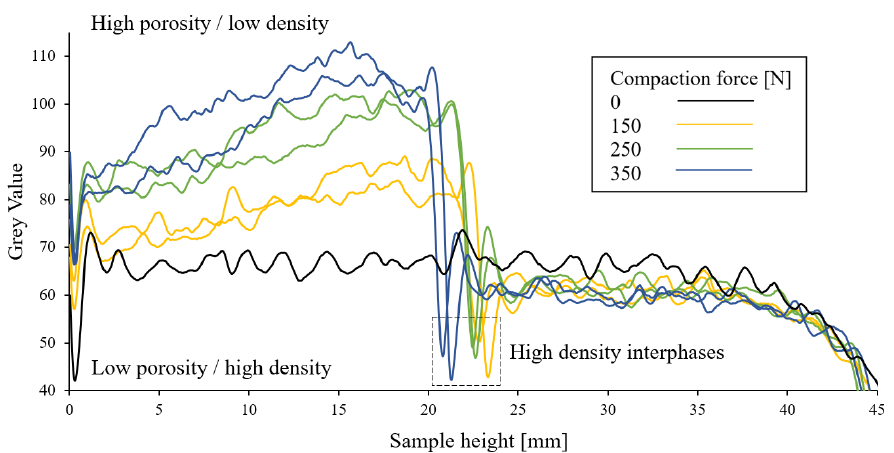
Figure 3. Average grey level intensity plotted versus sample height.